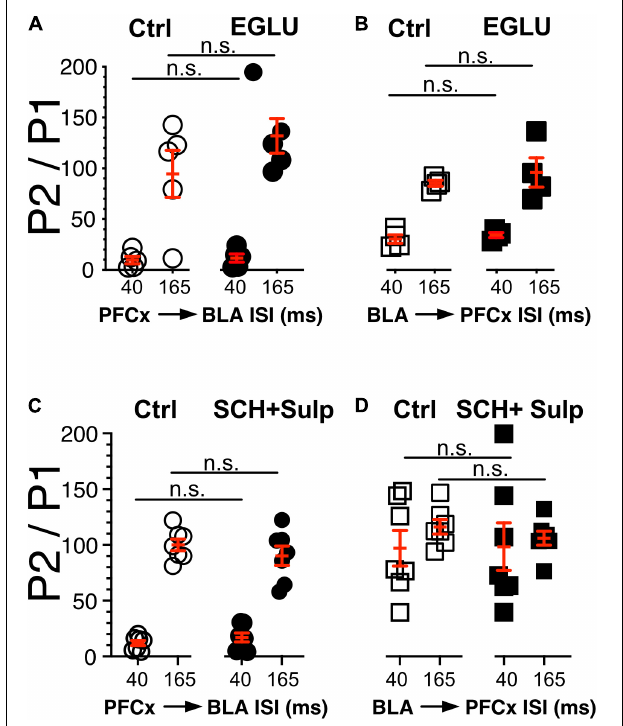
FIGURE 5 | Neither DA nor metabotropic receptors control synaptic gating. (A,B) Circles show the magnitude of the gating of BLA-EPSPs (P2) by PFCx inputs (PFCx → BLA) at various intervals expressed as percent relative to control (P1) in 5 MSNs before and during exposure to EGLU. Square symbols show the magnitude of the gating of PFCx-EPSPs (P2) by BLA inputs (BLA → PFCx) at various intervals expressed as percent relative to control (P1) in 5 MSNs before and during exposure to EGLU. (C,D) Same as panels (A,B) in presence of SCH-23390 and Sulpiride.